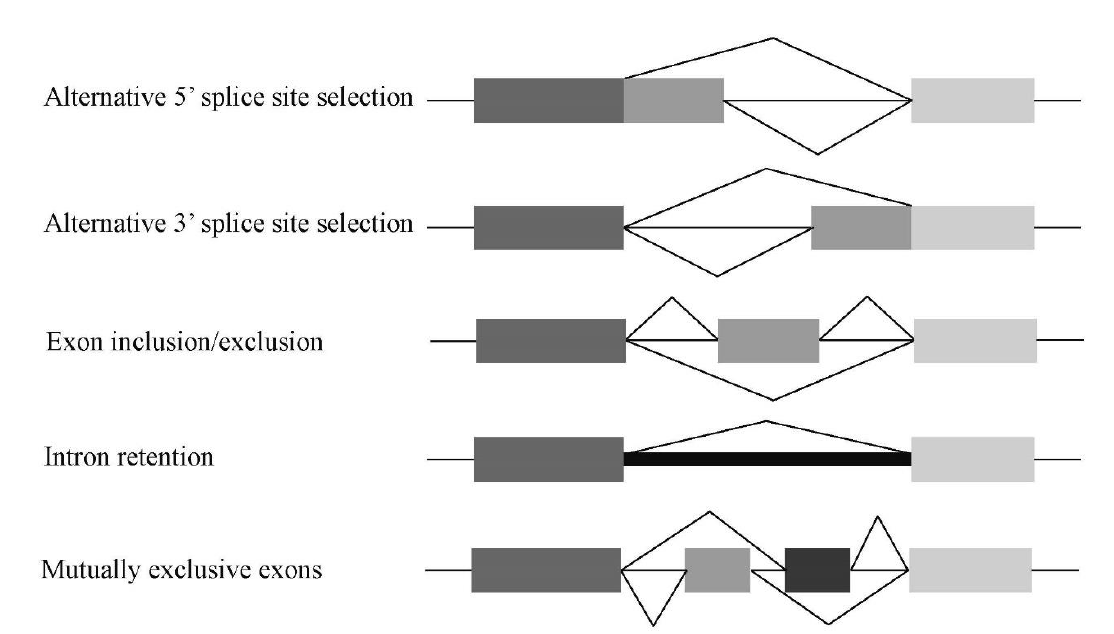
Figure 3. Major patterns of alternative splicing. Schemes of five major alternative splicing patterns in higher eukaryotes. In intron retention alternative splicing, the intron shown in a thick line is recognized as an alternative